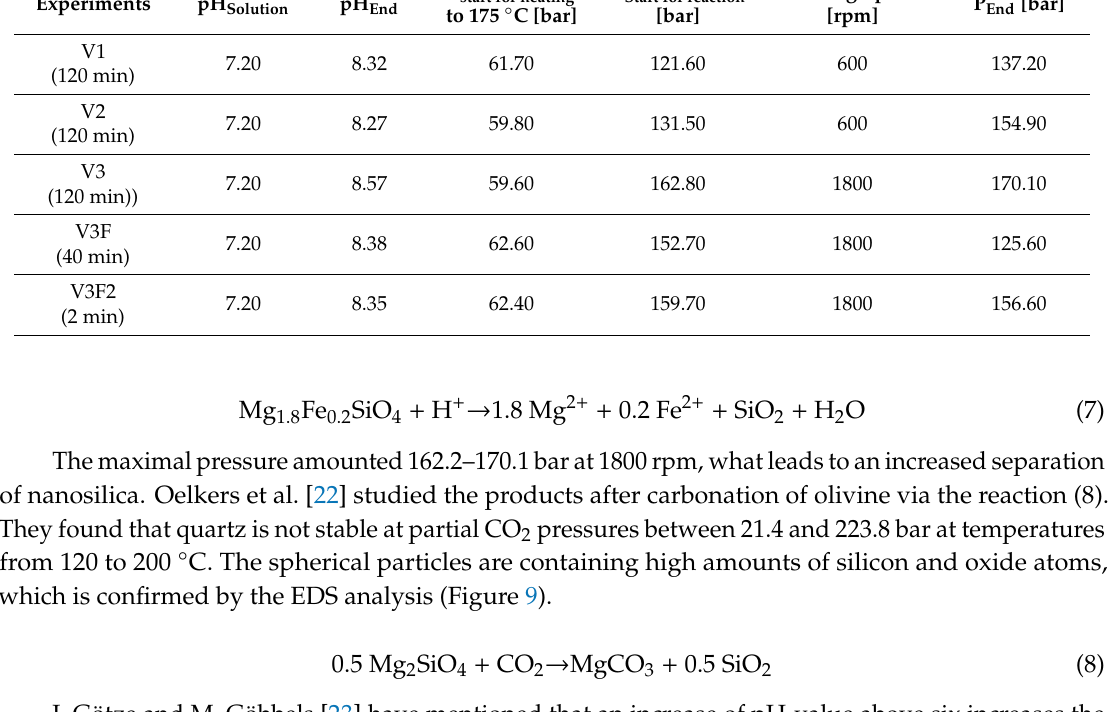
Table 3. The change of pH-Value of solution and pressure during a heating and carbonation.